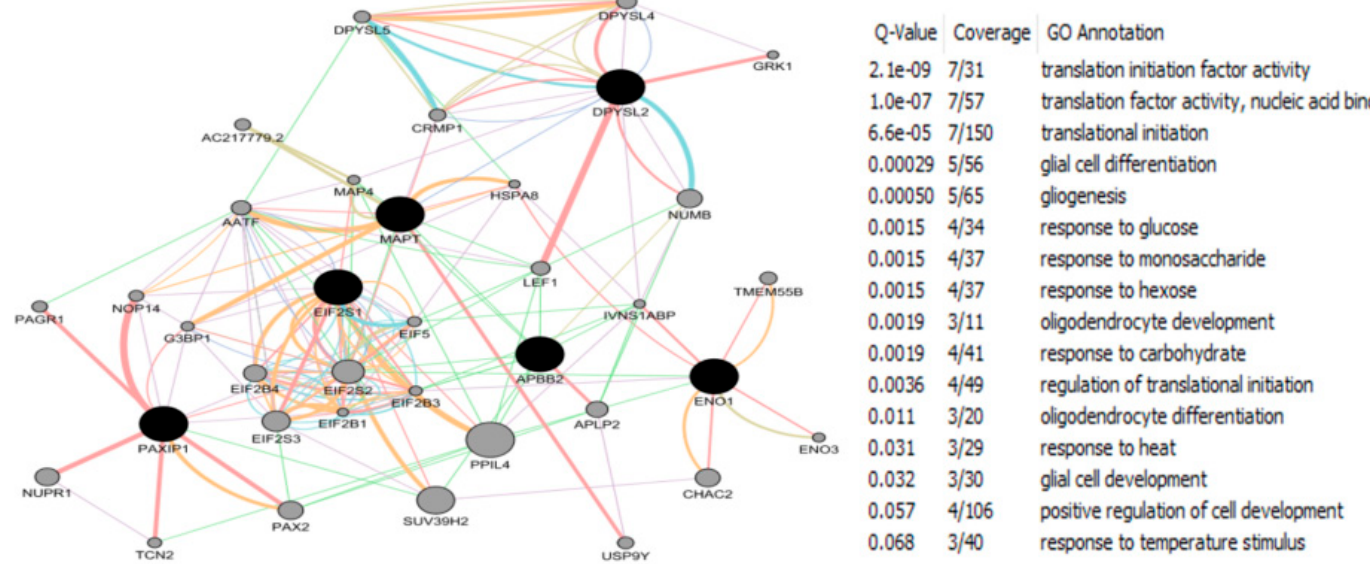
Figure 4. Gene set pathway enrichment analysis of 17- β estradiol (E2) responsive NRF1 target genes associated with Alzheimer’s Disease (AD). The network includes the top 30 E2 related genes in AD in gray. E2 responsive NRF1 genes are in black. Right panel show GO annotations of NRF1 enrichment network genes of E2 associated with biological process pathways involving multiple E2 and NRF1 genes and Q -value as a probability showing number of genes out of the total genes annotated to each GO term.